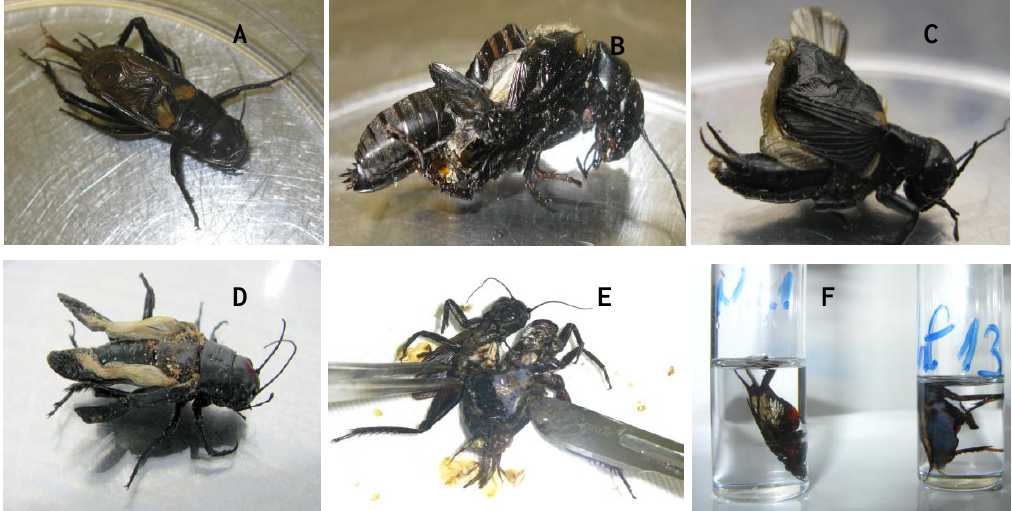
Figure 6. Malformations associated with IIV infection in crickets. ( A ) Negative control cricket. ( B ) Inability to complete ecdysis. ( C , D ) Distorted development of the wings in patently infected crickets. ( E,F ) Bluish iridescence in the fat body of patently infected crickets (on picture F right side of tube is infected, left is the negative